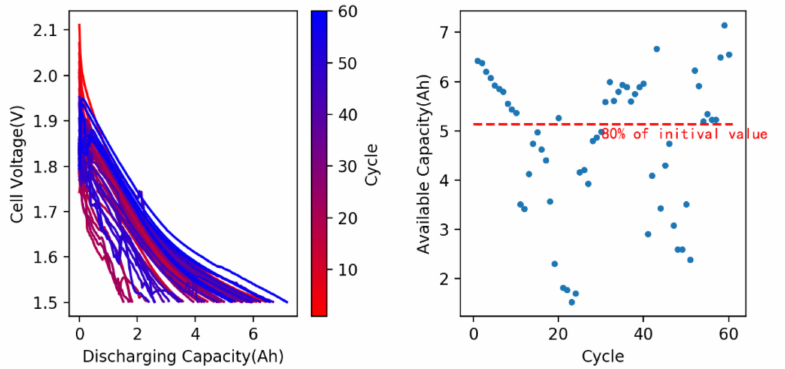
Figure 4. The discharging curves and capacity fading process of cell #2.